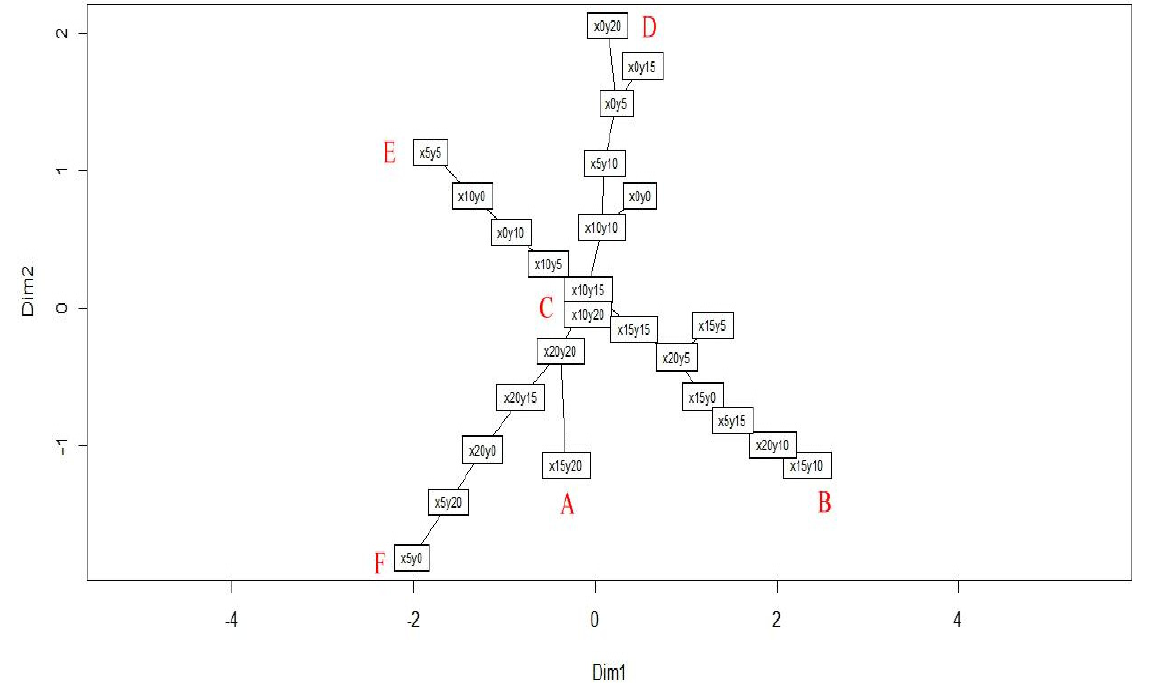
Figure 4. The minimum spanning tree of succession series from 25 quadrats in the forest community of Lienhuachih area.